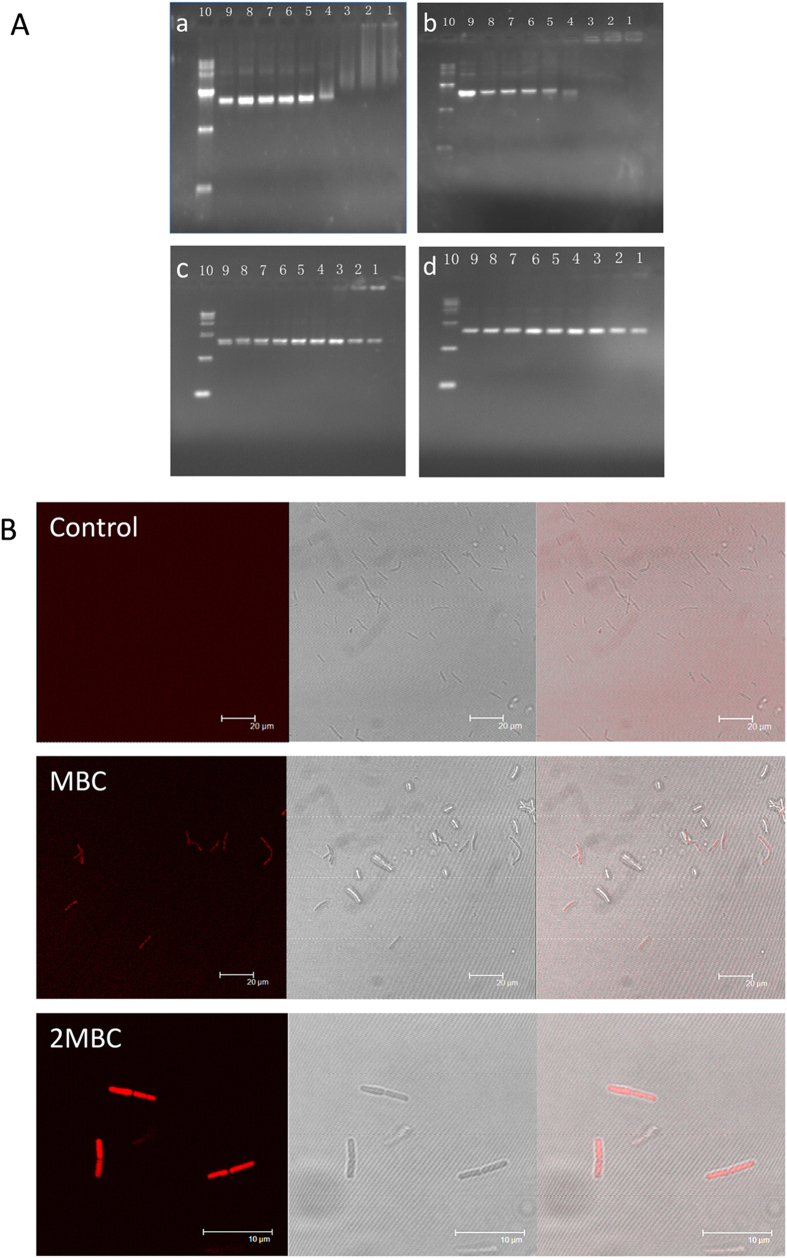
(A) DNA (pUC57) binding assay was determined by gel retardation experiments. Various concentrations of centrosymmetric peptides were incubated with 400 ng DNA for 1 h at room temperature. (a) GG2-treated; (b) GG3-treated; (c) AA2-treated; (d) AA3-treated; Lane 1: with 128 μM peptide; lane 2: with 64 μM peptide; lane 3: with 32 μM peptide; lane 4: with 16 μM peptide; lane 5: with 8 μM peptide; lane 6: with 4 μM peptide; lane 7: with 2 μM peptide; lane 8: with 1 μM peptide; lane 9: plasmid DNA alone; and lane 10: DNA Marker alone. (B) Confocal fluorescence microscopic images of E. coil ATCC25922 treated with PI-labeled GG3. Panels on the left, middle and right represent laser-scanning, transmitted light-scanning and merged images of cells treated with PI-labeled GG3, respectively.